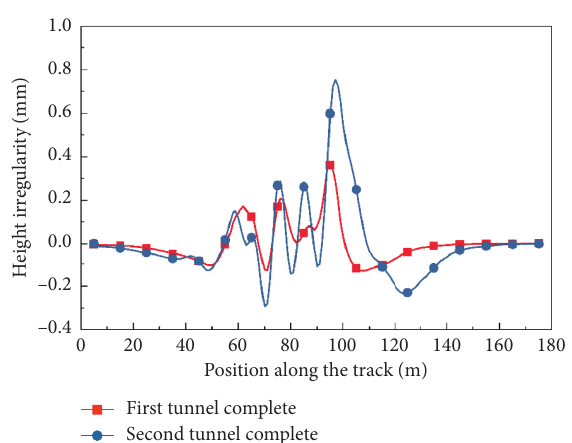
Figure 7: Simulated height irregularity of the track at different